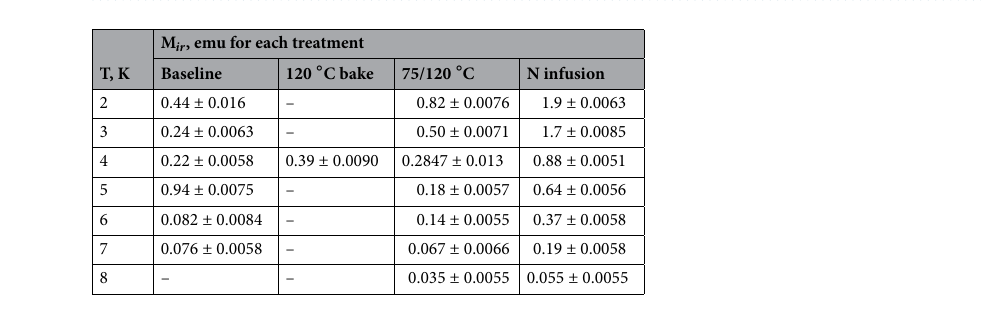
Table 2. Irreversible magnetic moment obtained at µ 0 H ext = 0 mT indicative of the pinning strength.